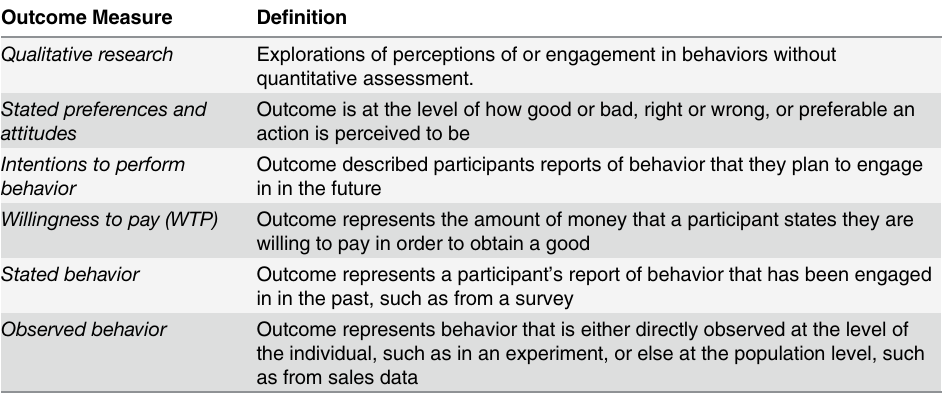
Table 4. Definition of outcome measures for unlawful file